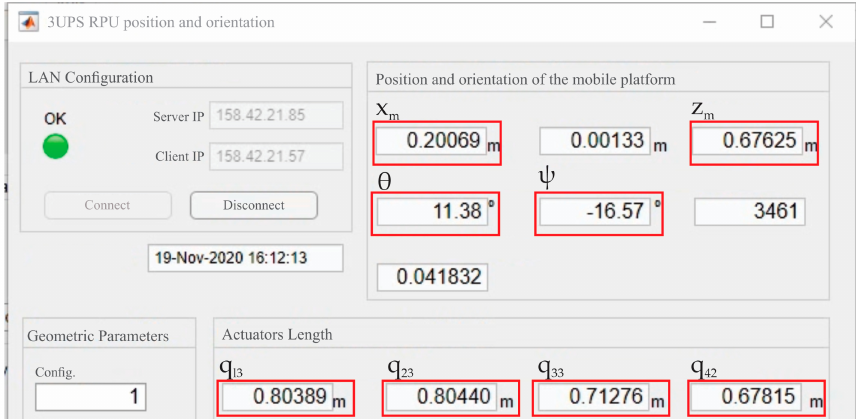
Figure 8. GUI for position and orientation tracking designed in